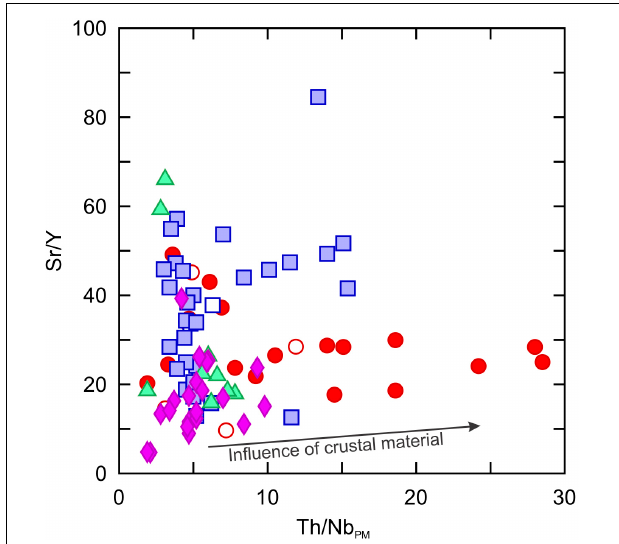
FIGURE 10 | Sr/Y vs. primitive mantle-normalized Th/Nb (Th/Nb PM ) plot of the Cretaceous granitic (granites, granodiorites, tonalites, diorites) rocks from Kyushu. Primitive mantle values are from Sun and McDonough (1989). Symbols as in Figure 2 .